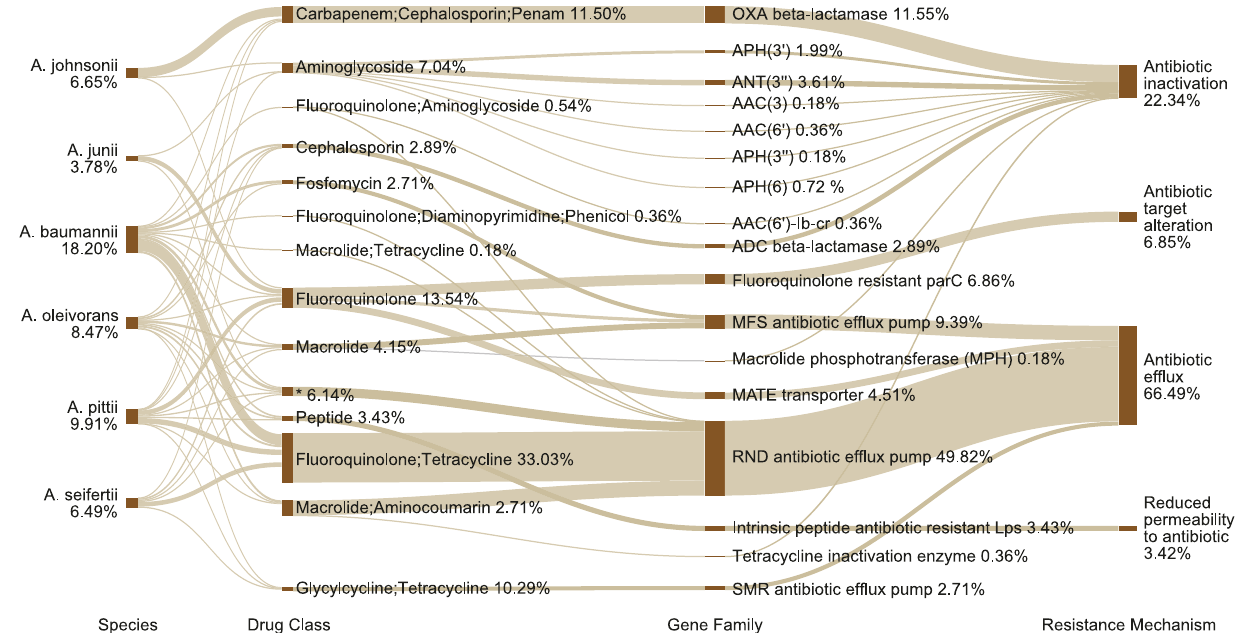
Fig. 2 The antibiotic resistome in Acinetobacter community. The predominant six species are presented in the left. The percentages below species names are their proportions in Acinetobacter community. The right columns show the ARGs detected in these species, while the percentages are proportions of the ARGs in all Acinetobacter species. The complete results are summarized in Supplementary Table S7. Asterisk-marked antibiotic category includes macrolide, fl uoroquinolone, lincosamide, carbapenem, cephalosporin, tetracycline, rifamycin, diaminopyrimidine, phenicol and